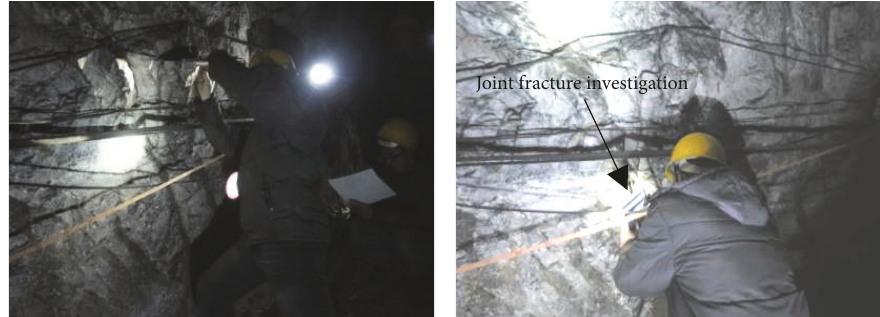
Figure 2: Geological field investigation in an inclined shaft in the mined-out area.